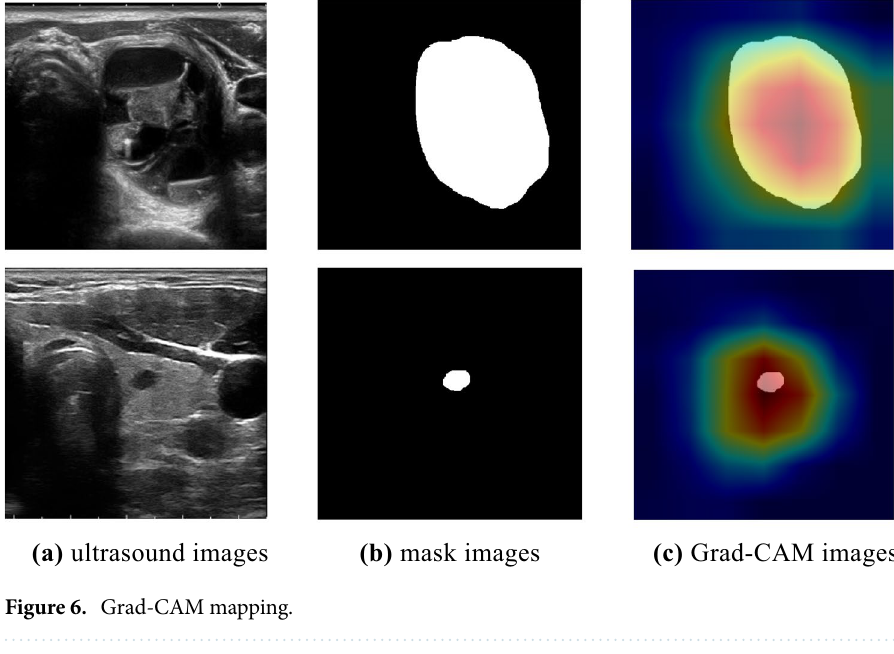
Figure 6. Grad-CAM mapping.